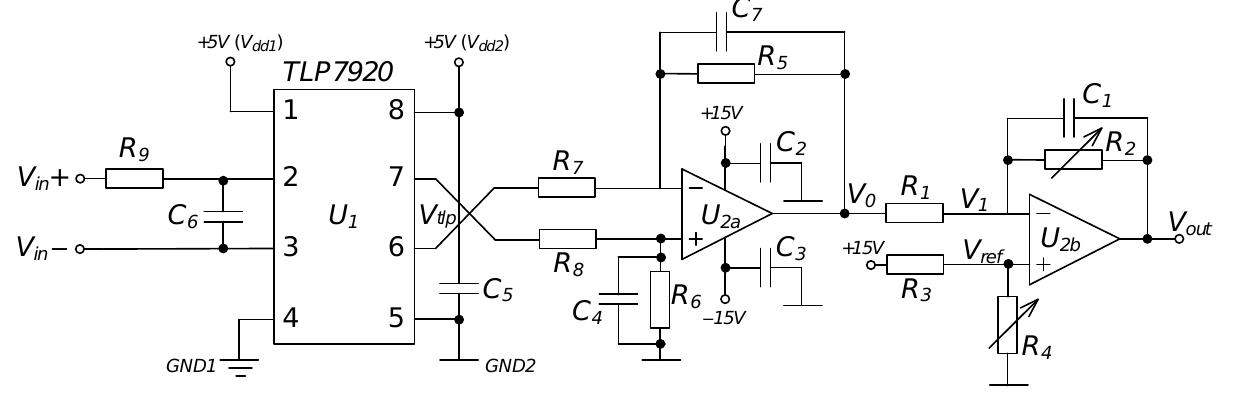
Table 2. The input voltage for this measurement was generated using a PeakTech 6225 A